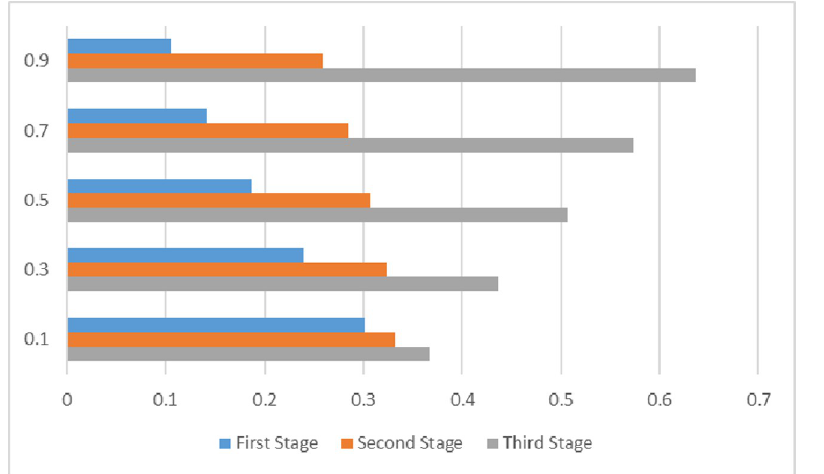
Fig 4. Influence of attenuation coefficient on weight of each